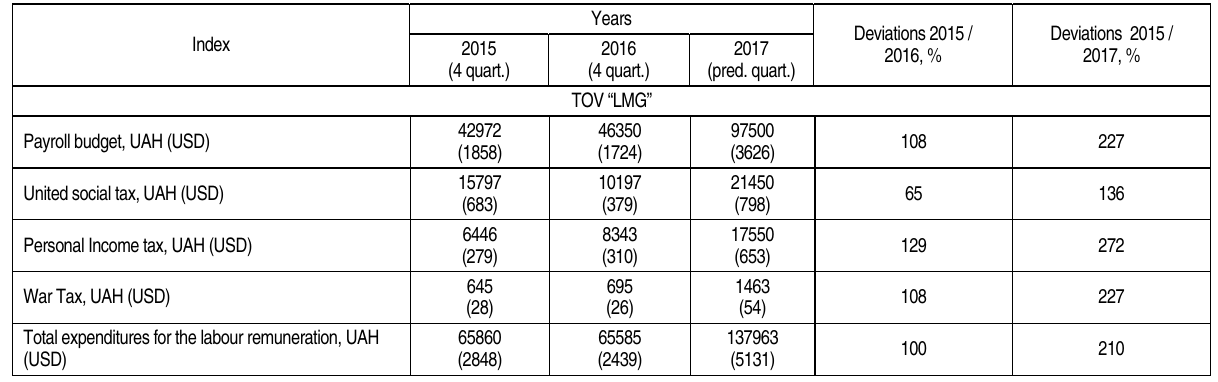
Table 2 (cont.). Comparative analysis of the payroll budget and social contributions in the activity of TOV